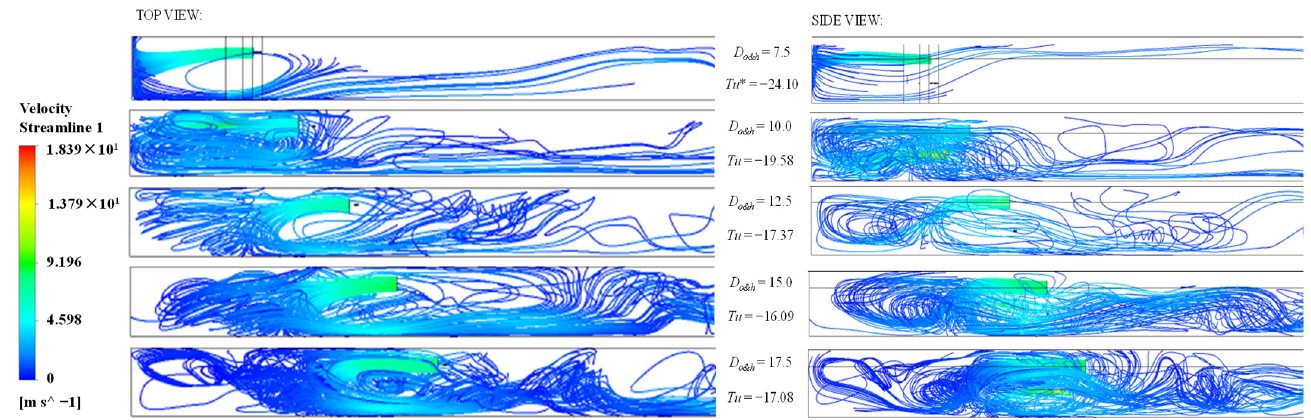
Figure 7. Streamlines of airflow in the single-heading tunnel as D o&h increases (the streamlines’ color represents the flow velocity) and change in the turbulence intensity of the single-heading tunnel as D o&h increases (*: Tu—turbulence intensity, ratio of the standard deviation of the localized air flow velocity to the localized mean flow velocity When keeping the oxygen mass flow rate constant and increasing the diameter of the oxygen supply duct (Factor D), MAA increases overall, too. Because increasing the duct diameter in the case of a constant mass flow rate means lower flow velocity, and lower flow velocity inevitably leads to bad air exchange and increased MAA. The range analysis